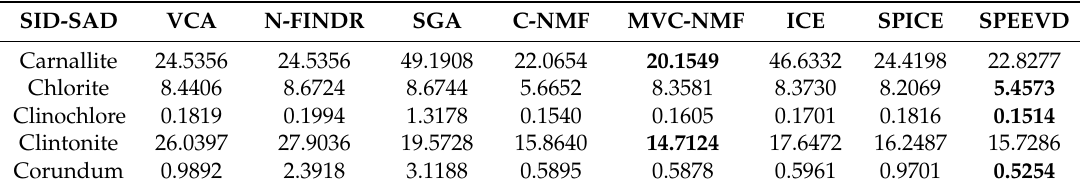
Table 3. SID-SAD metric values between the extracted endmembers and the USGS library. SID-SAD